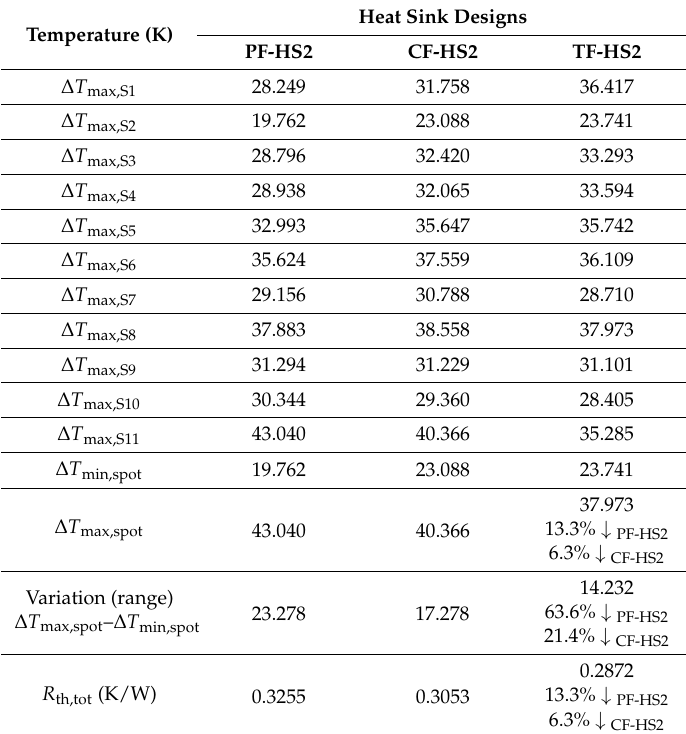
Table 9. Total thermal resistances and maximum temperature increases at the hotspots of the PF, CF, and TF heat sinks for the hotspot scheme HS2 at the total flow rate of 0.01 kg/s.